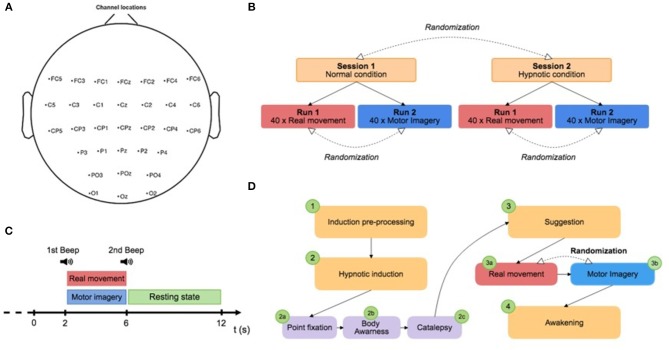
(A) Electrode position. (B) Paradigm scheme representing the two different sessions: normal condition and hypnotic condition. Each session is composed of two runs of 8 min and a randomization of the order was applied between runs and sessions. (C) Trial design: the subject had to perform a real movement task or a motor imagery task for 4 s, approximately once every 10 s according to triggers. A low frequency beep indicated when the subject had to execute the task (RM or MI). A high frequency beep indicated the end of the task. (D) Description of the hypnosis session. The hypnotic condition (Session 2) was subdivided into several stages: (1) the induction pre-process, (2) the hypnotic induction, (3) suggestion during the experiment, and (4) the awakening.